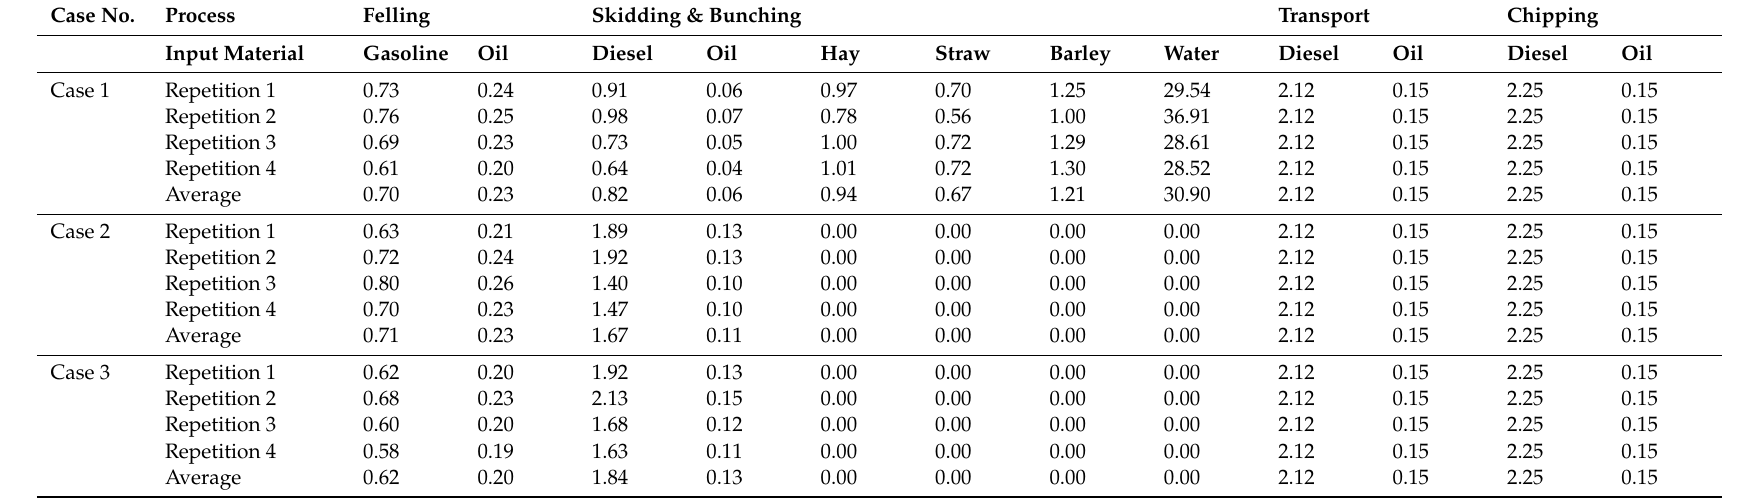
Table 3. Inventory data of direct inputs, in kg per ton d.m